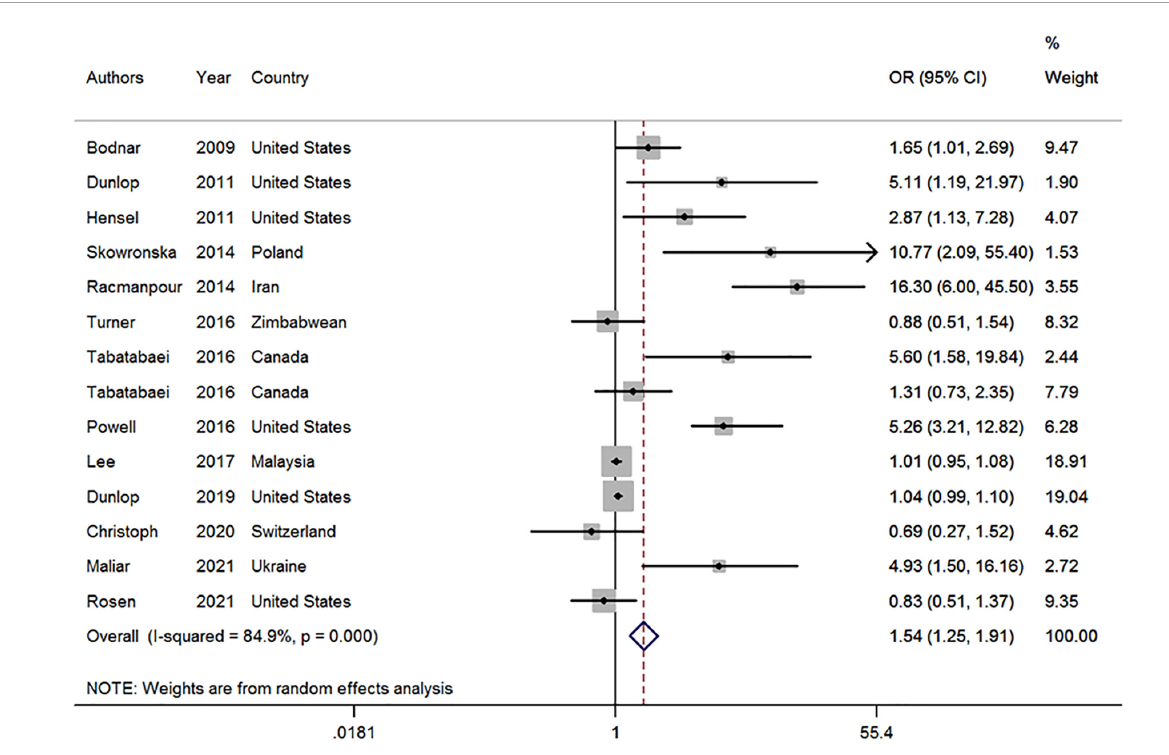
FIGURE2 Forest plot of included studies on the association between vitamin D deficiency and bacterial vaginosis risk. OR, odds ratio; CI, confidence interval. The size of the grey box is positively proportional to the weight assigned to each study, which is inversely proportional to the SE of the OR. The horizontal lines represent the 95%